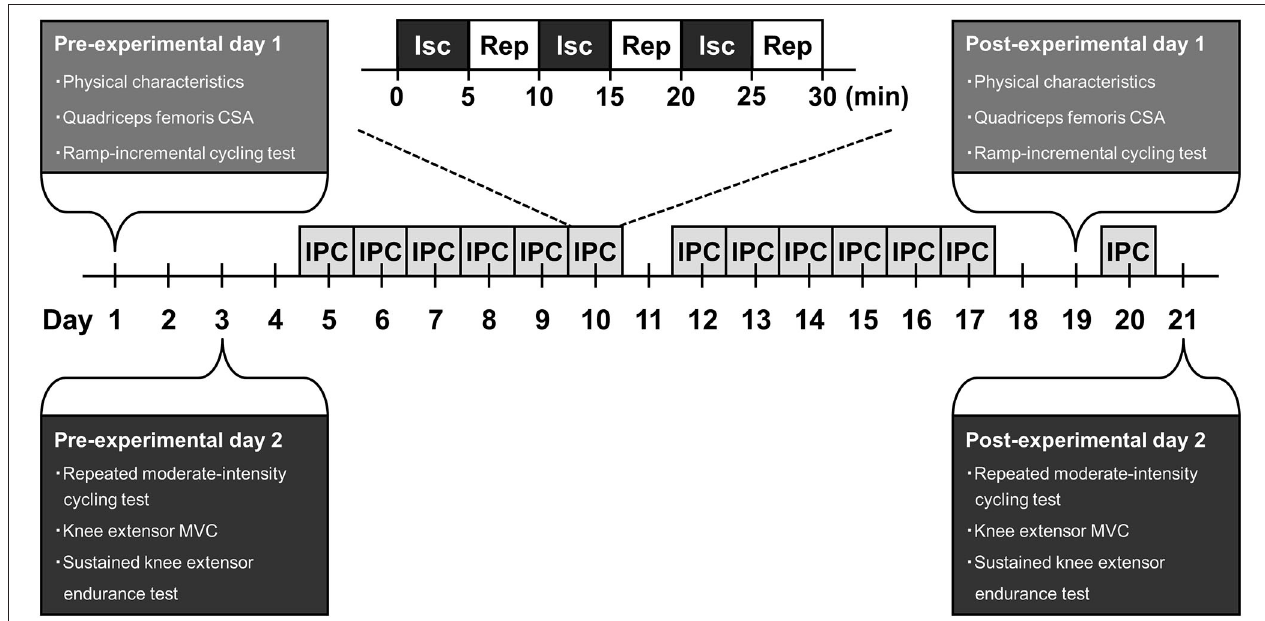
FIGURE 1 | A schematic representation of experimental design. CSA, cross-sectional area; MVC, maximal voluntary contraction; Isc, ischemia; Rep, reperfusion; IPC, ischemic